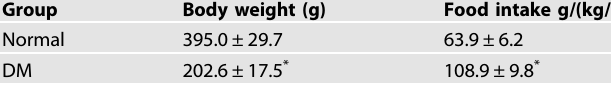
Table 2. General condition of normal and DM rats.